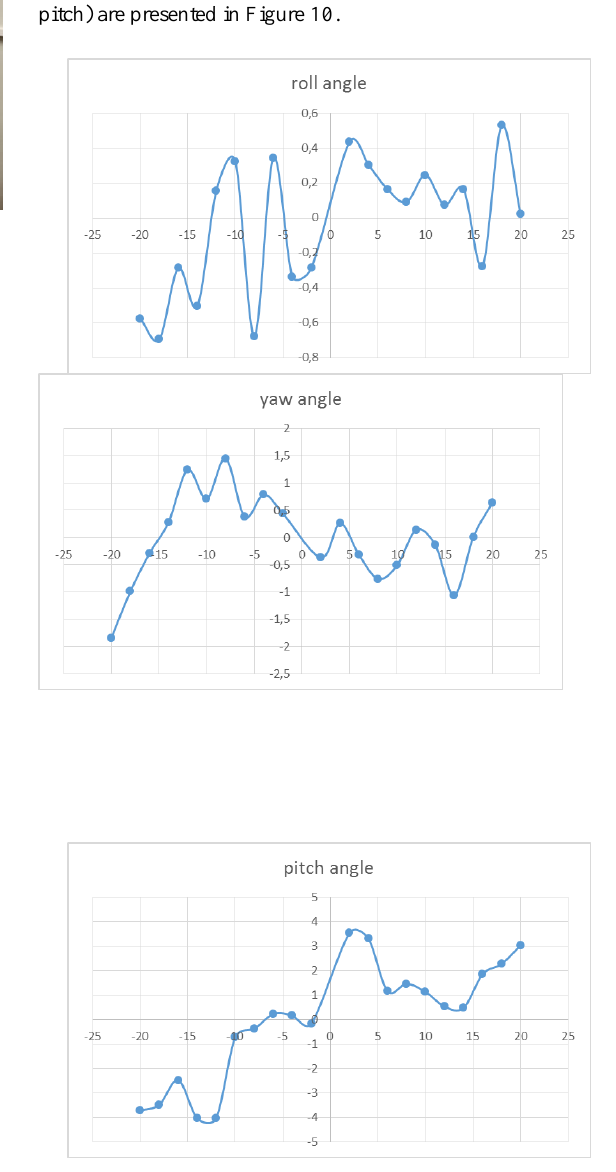
Figure 10. Experimental results: precision of pose estimation The experimental estimates of head pose